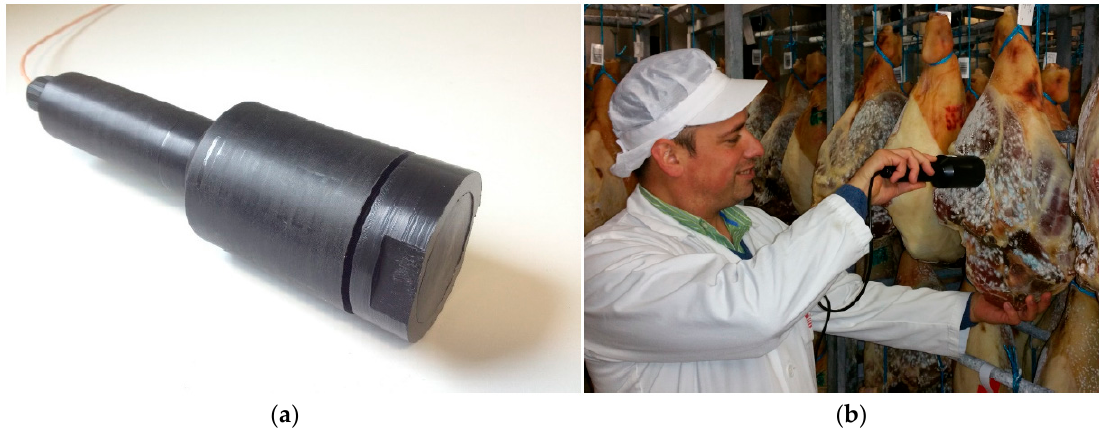
Figure 1. ( a ) The microwave probe and ( b ) the probe demonstrated at dry-cured production facility in